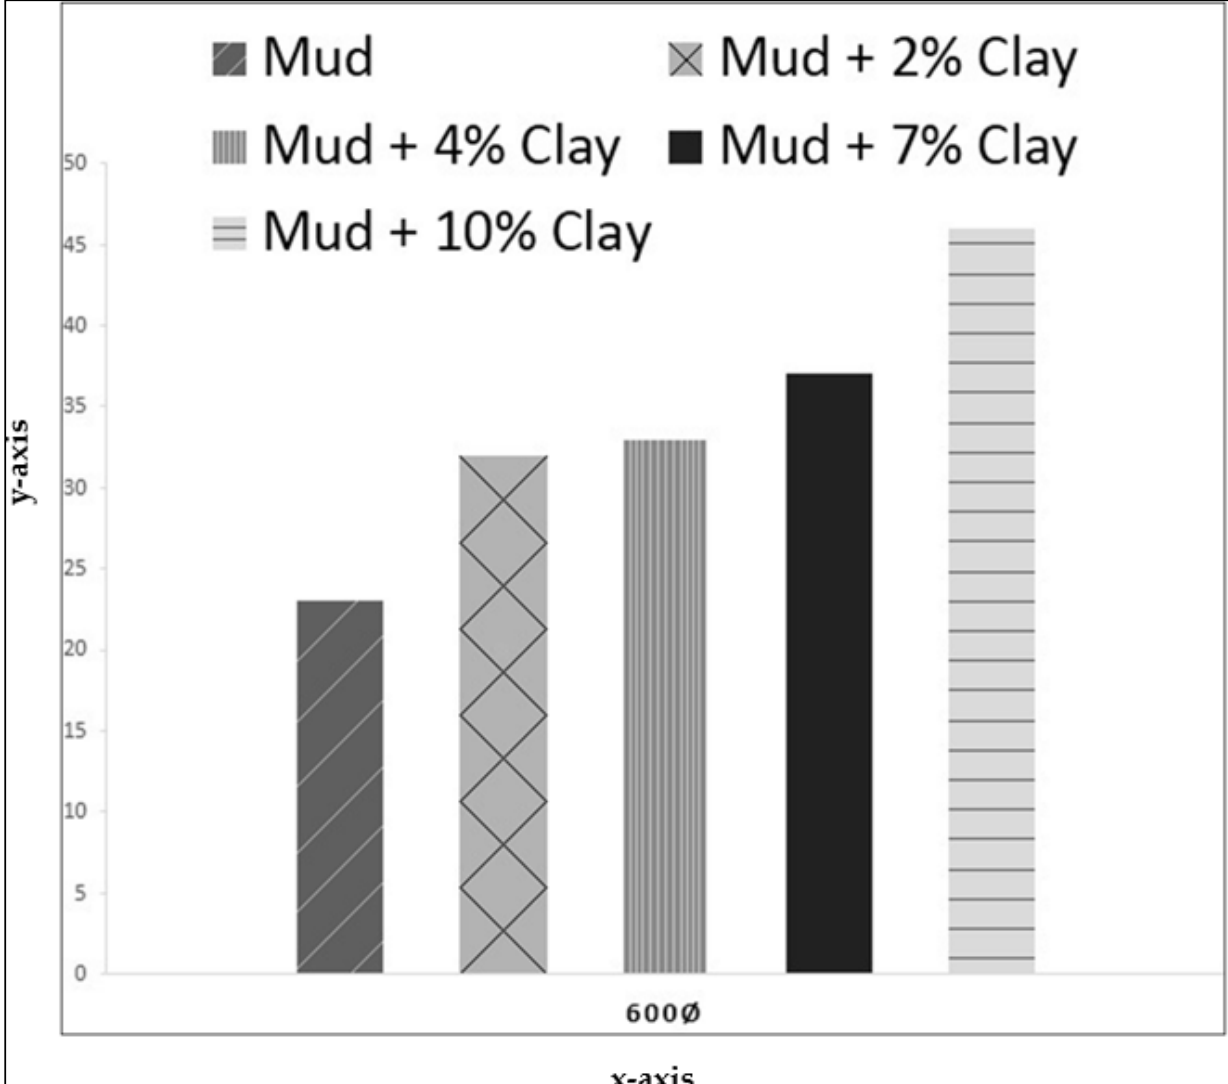
Figure 5. The image shows the rheological values ( y -axis) compared with the rheological properties ( x -axis).